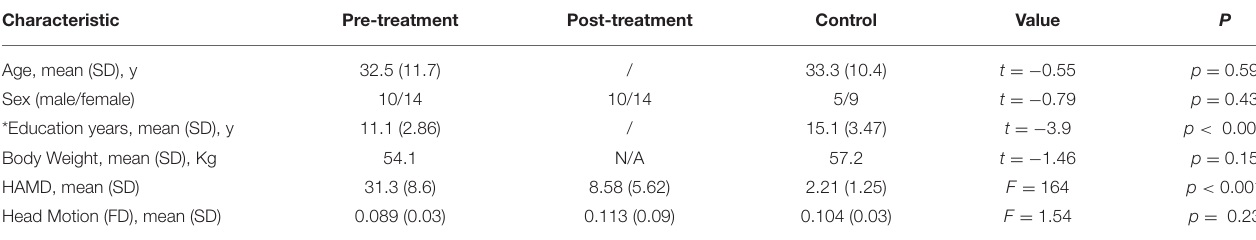
TABLE 1 | The demographic data and psychological measurements of the healthy controls, pre-treatment and post-treatment depressive subjects.